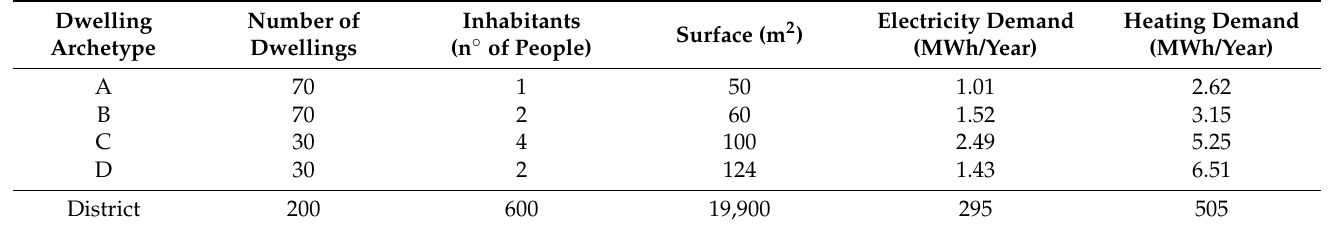
Table 1. Main characteristics along with electricity and heating demand of both REC and dwelling archetypes.